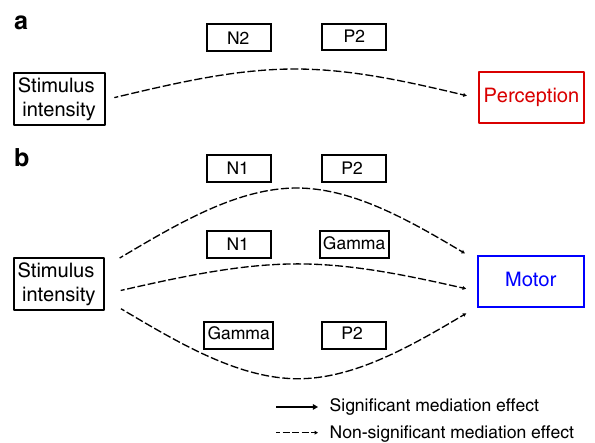
Fig. 7 Brain mediators of perceptual, motor, and autonomic responses — three-path mediation analysis. Three-path mediation analyses were performed whenever more than one brain response signi fi cantly mediated in the two-path mediation models. Thus, three-path mediation analyses were performed for the N2 and P2 waves in the perception condition as well as for the N1 and P2, N1 and gamma, gamma and P2 responses in the motor condition. A schematic overview of potential mediation effects (path a1 × d × b2) in the perception ( a ) and motor ( b ) condition is depicted. Dashed arrows indicate that no signi fi cant three-path mediation effects were